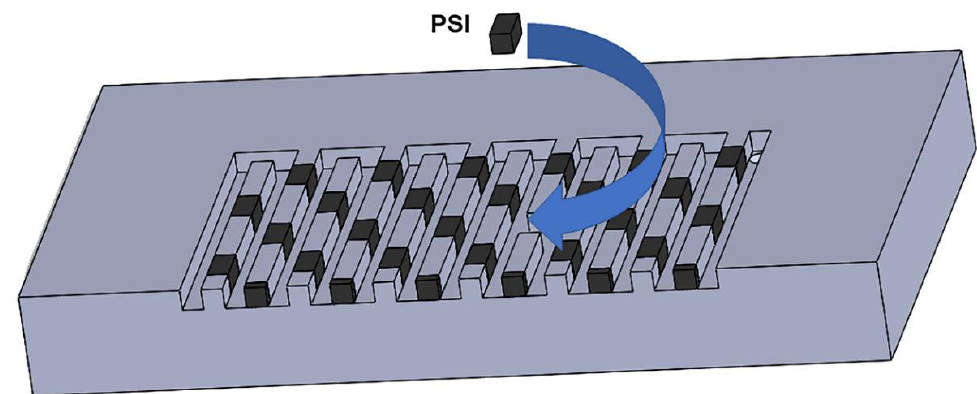
Figure 3. 3D sectioned view of MSSFF with 4 mm PSI.